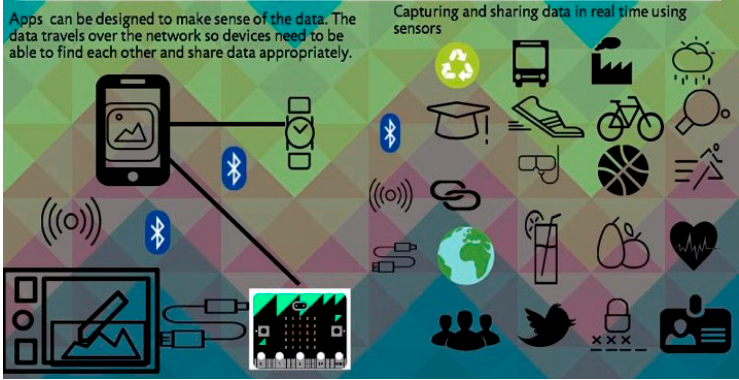
Figure 5. ‘Thinking aloud—BBC Micro:bit’ ideate/create physical computing with science and art.